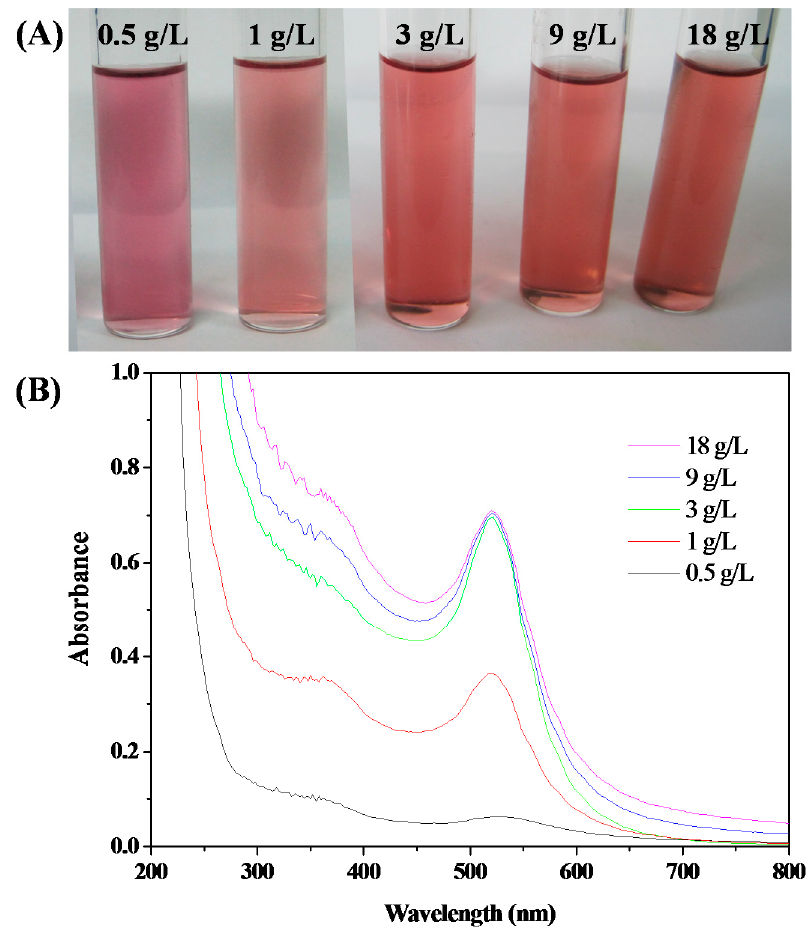
Figure 1. Effect of the concentration of HPEI-IBAm on synthesis of AuNPs: ( A ) the color and ( B ) the UV-Visible spectra.